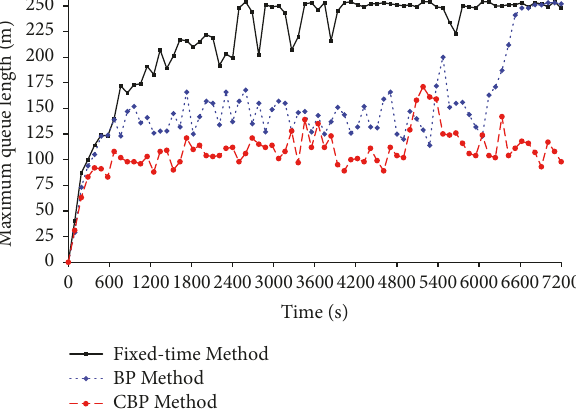
Figure 12: Maximum queue length during